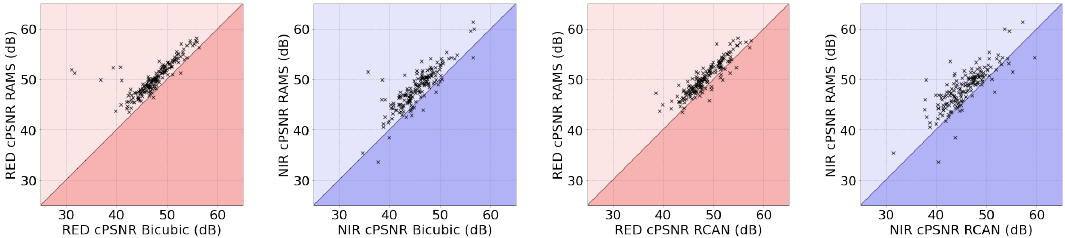
Figure 5. cPSNR comparison between RAMS and bicubic inteprolation and RAMS and RCAN(SISR) on the validation set. Each data point represents a scene of the dataset: when a cross is above the line, the correspondent scene is reconstructed better by RAMS.